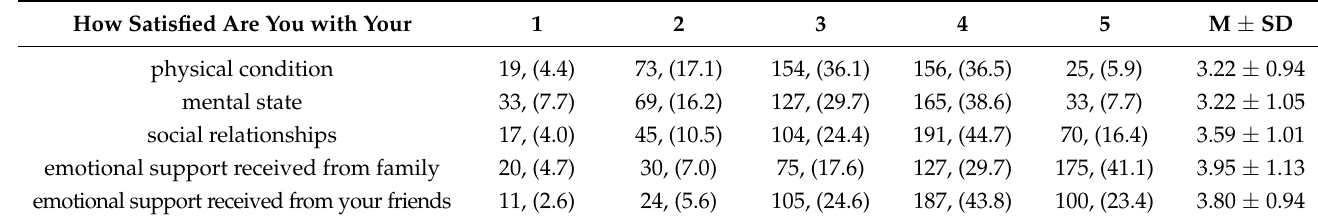
Table 2. Self-rated items regarding satisfaction with health-related status 1 .